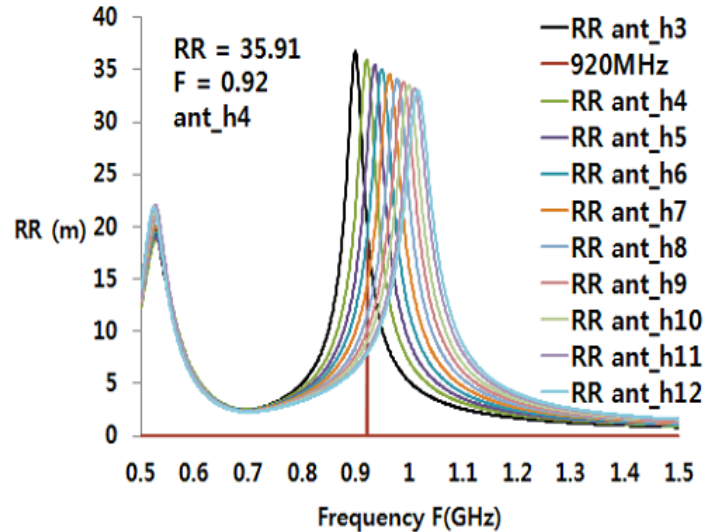
Figure 9. Simulation of the reading range by the variation of ant_h value (mm).